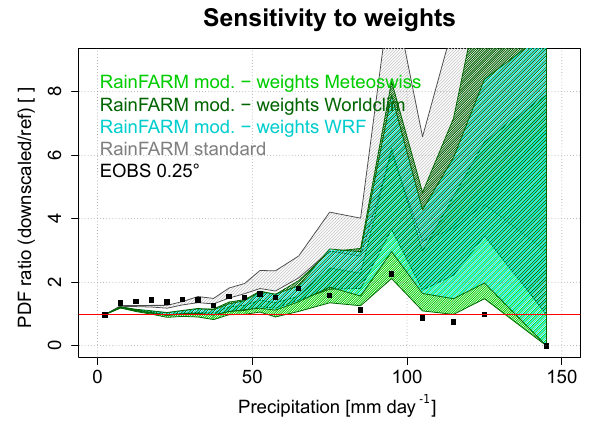
Figure 5. Sensitivity of the modified RainFARM downscaling method to different weights, derived from MeteoSwiss (light green), WorldClim (dark green), and WRF (cyan) climatologies for low- precipitation grid points. The performances of the standard Rain- FARM method (gray) are shown for comparison. The bands show the range of variability in the PDF ratios between each of the 80 downscaling realizations and the PDF of observations, while black squares represent the ratio between the PDF of E-OBS at its original spatial resolution and the PDF of